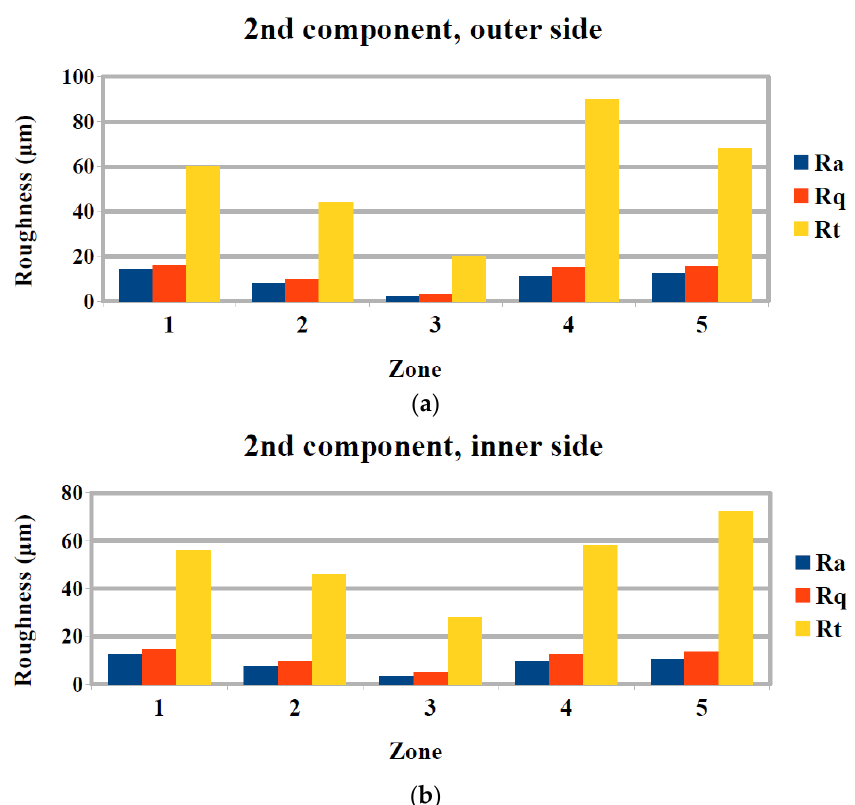
Figure 11. Surface roughness measurement results for the second femoral component for ( a ) outer and ( b ) inner side.